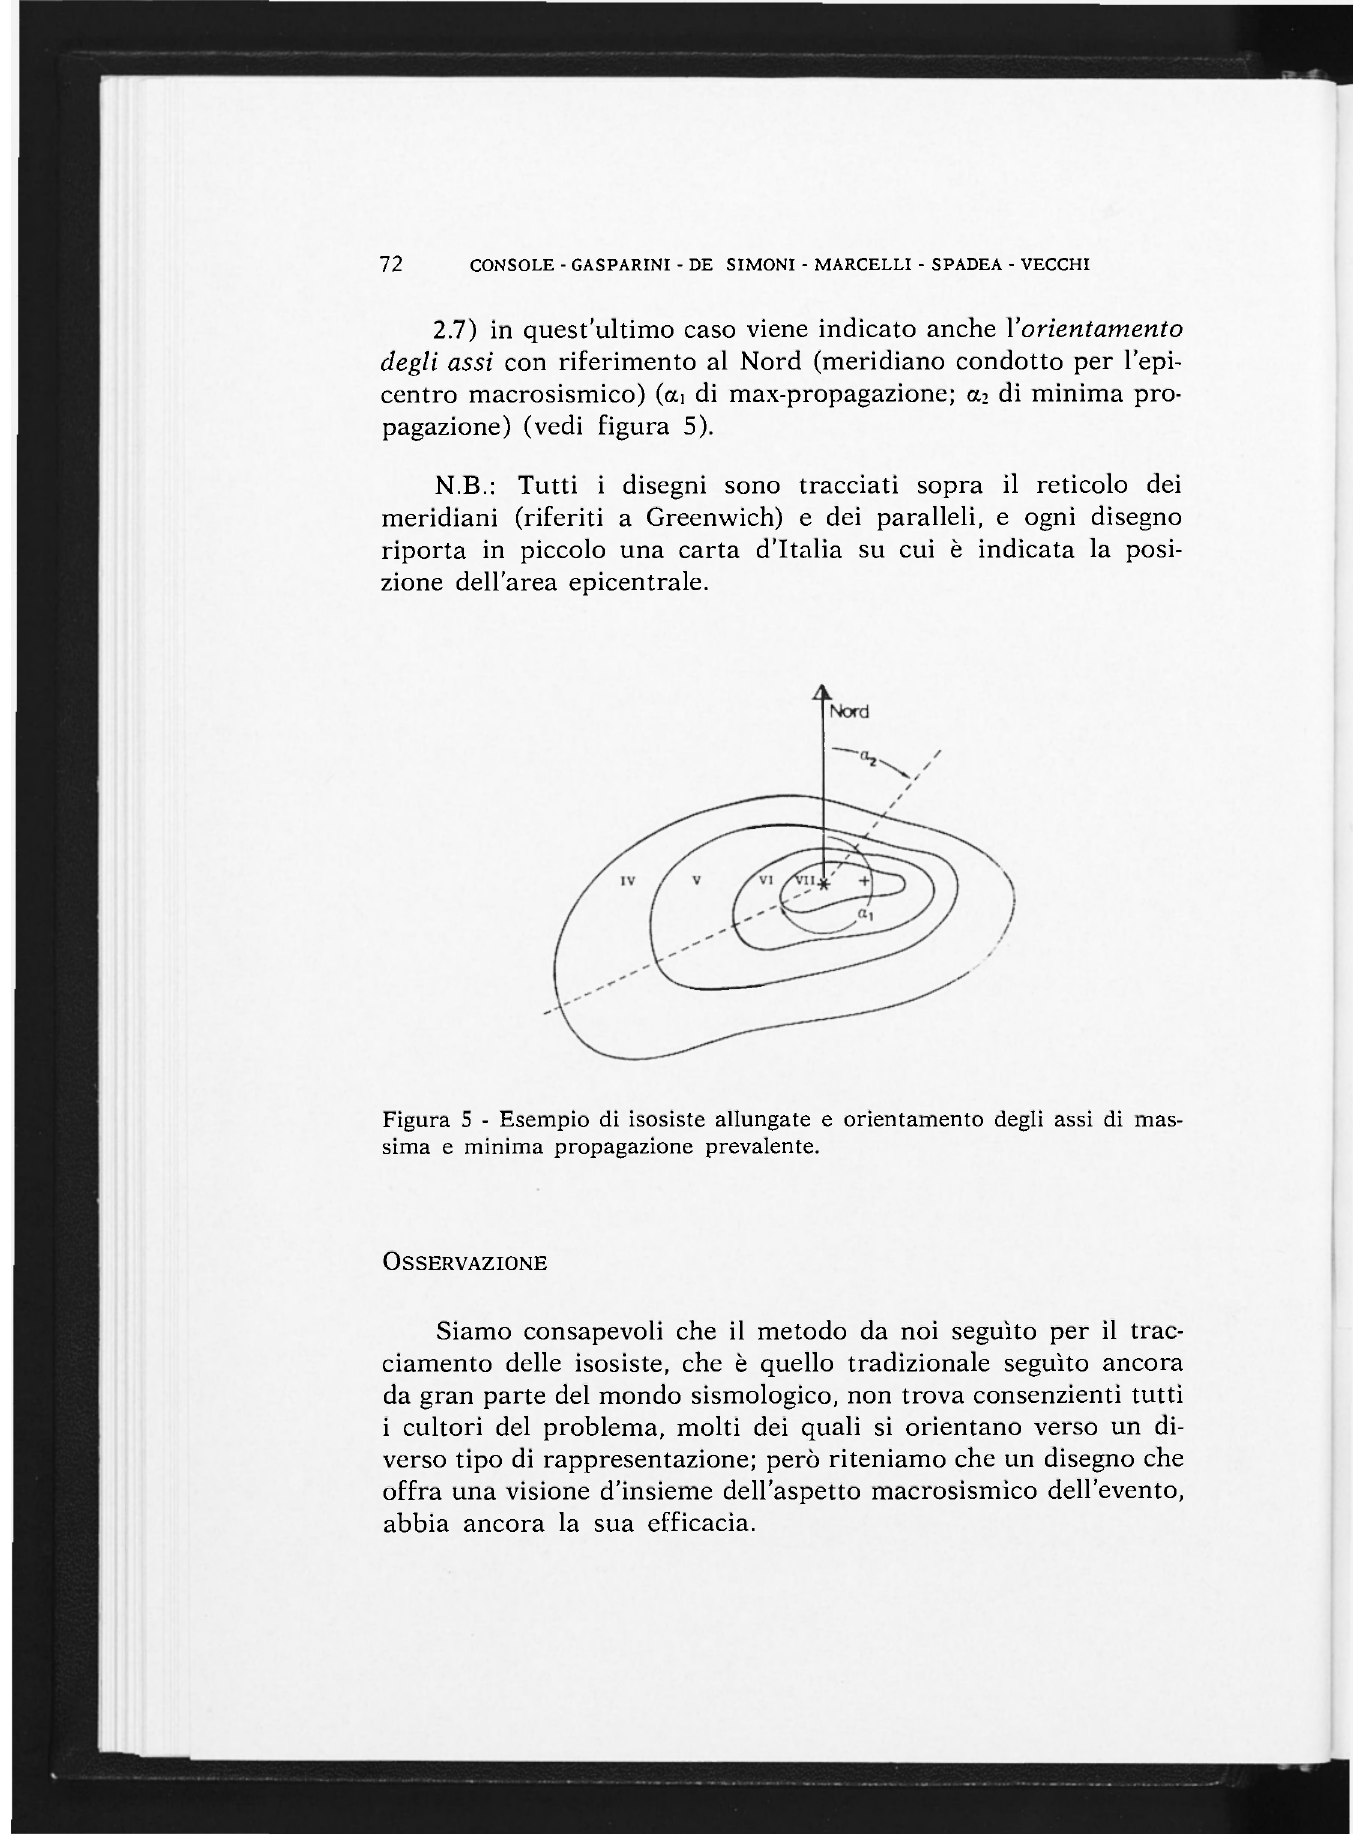
Figura 5 - Esempio di isosiste allungate e orientamento degli assi di mas- sima e minima propagazione